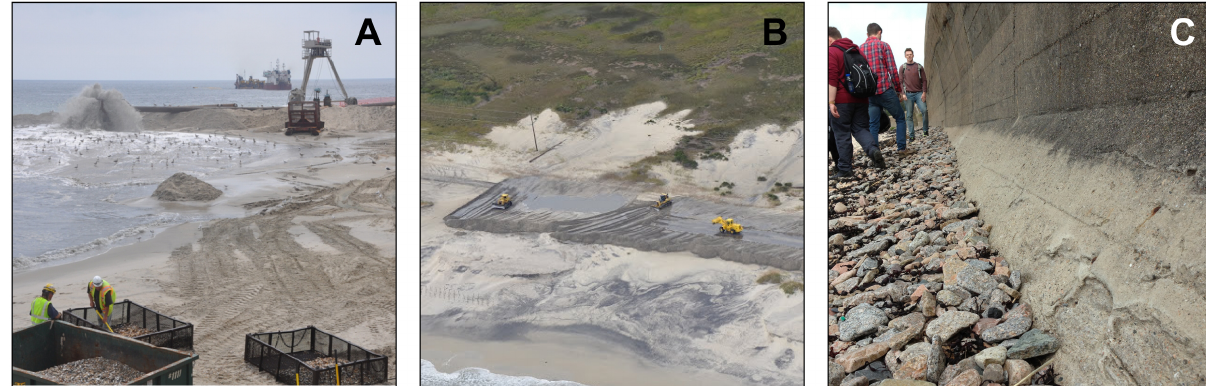
Figure 1. Three examples of typical coastal hazard mitigation practices: (A) beach replenishment in Monmouth, New Jersey (USA), nine months after Hurricane Sandy (photo: A. Coburn, Program for the Study of Developed Shorelines, http: // www.psds-wcu.org / ); (B) artificial dune reconstruction following an overwash event on Highway 12, North Carolina Outer Banks (USA) (photo: A. Coburn, PSDS); and (C) concrete seawall on the Channel Island of Jersey – note the pitting and fresh scour (light gray band) along the wall base just above the shingle